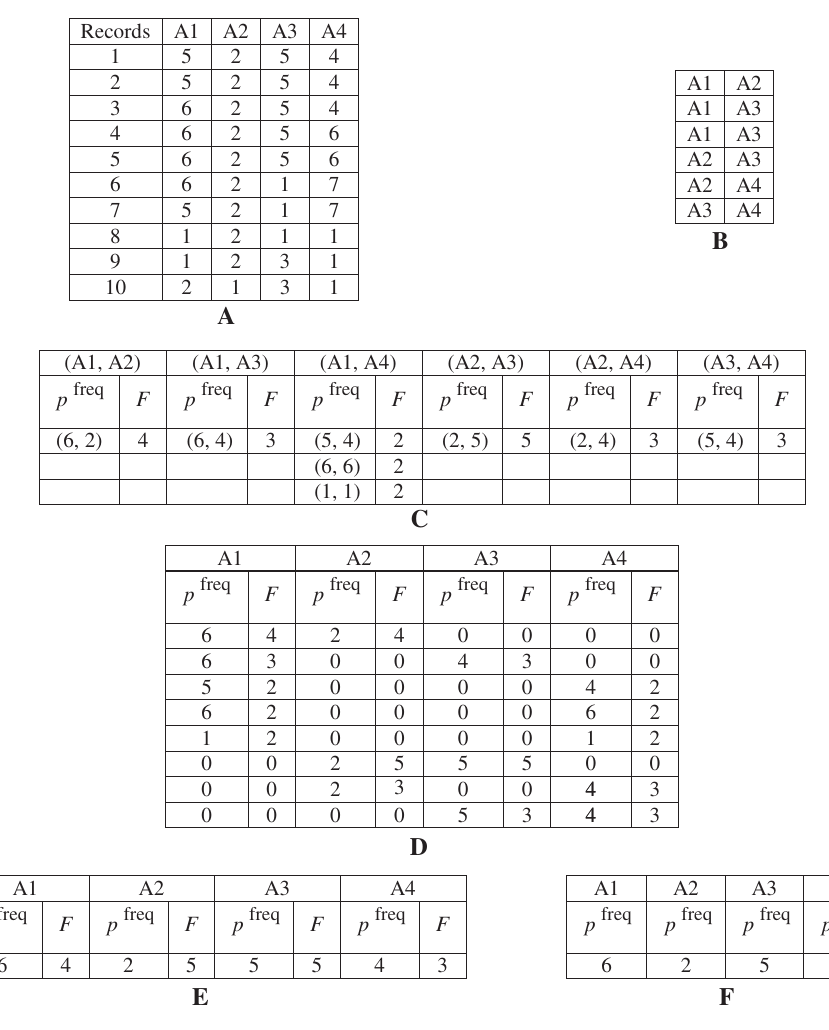
Figure 5: An Example to Illustrate the Algorithm for Mining Frequent and Feasible Patterns.